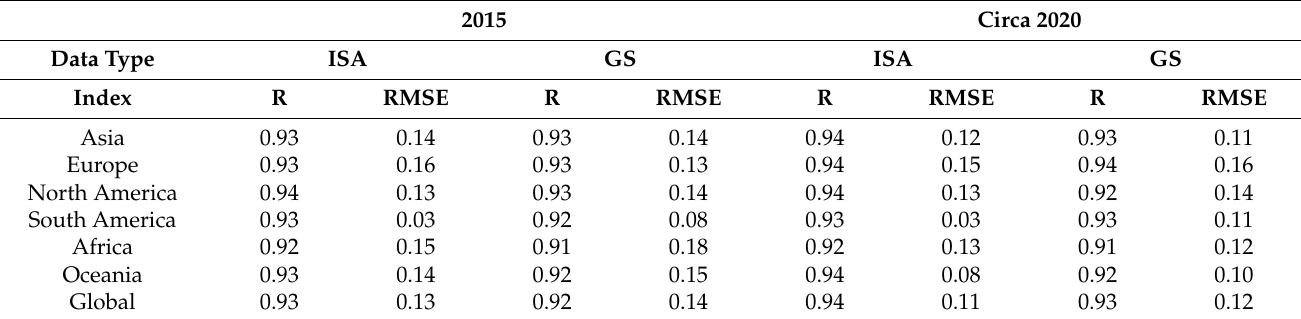
Table 3. The accuracy of urban impervious surface area (ISA) and green space (GS) fractions acquired from Landsat images in 2015 and circa